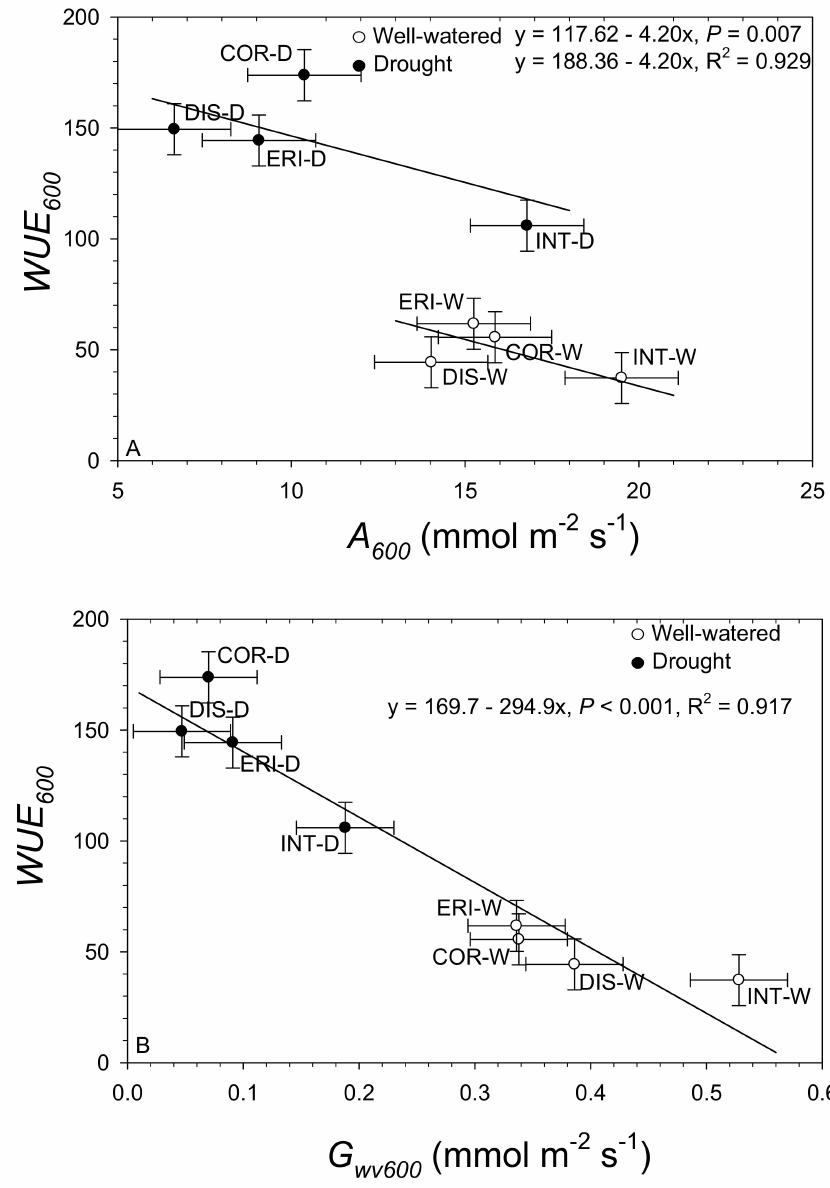
Figure 7. Relationship between water use efficiency at 600 ppm and ( WUE 600 ) and ( A ) assimilation at 600 ppm ( A 600 ), 2017, and ( B ) stomatal conductance at 600 ppm ( G wv600 ) across four willow species under well-watered and drought treatments,